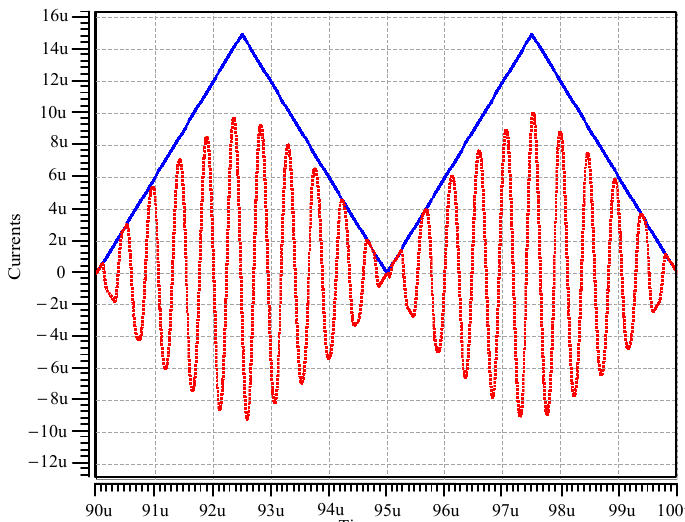
Figure 9. Simulated result of operation as an AM signal generator when I B 2 is the applied sinusoidal signal.